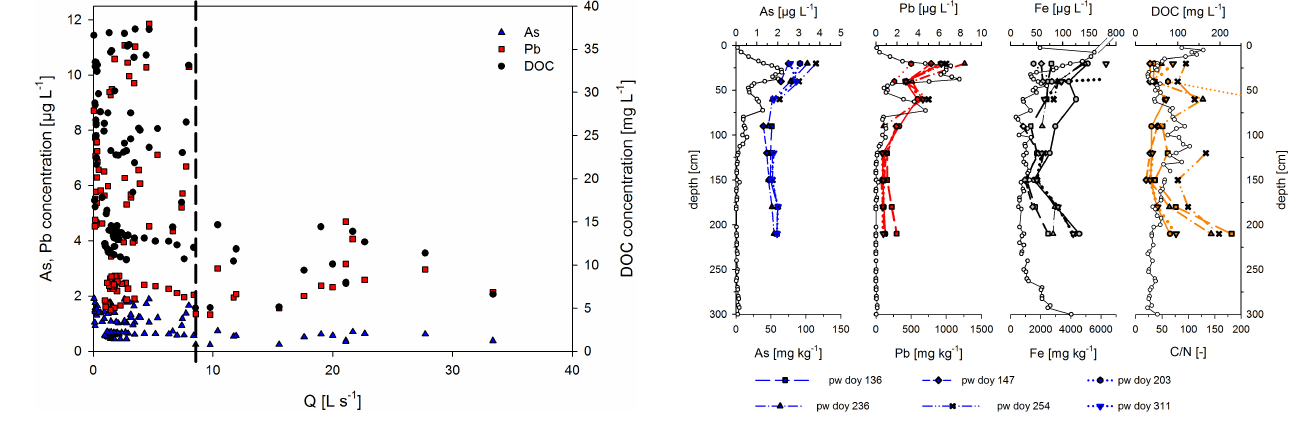
Figure 4. DOC, Pb and As stream concentration-to-discharge ( Q ) plot ( c/Q ). The black dashed line indicates the threshold discharge value for a general dilution effect.